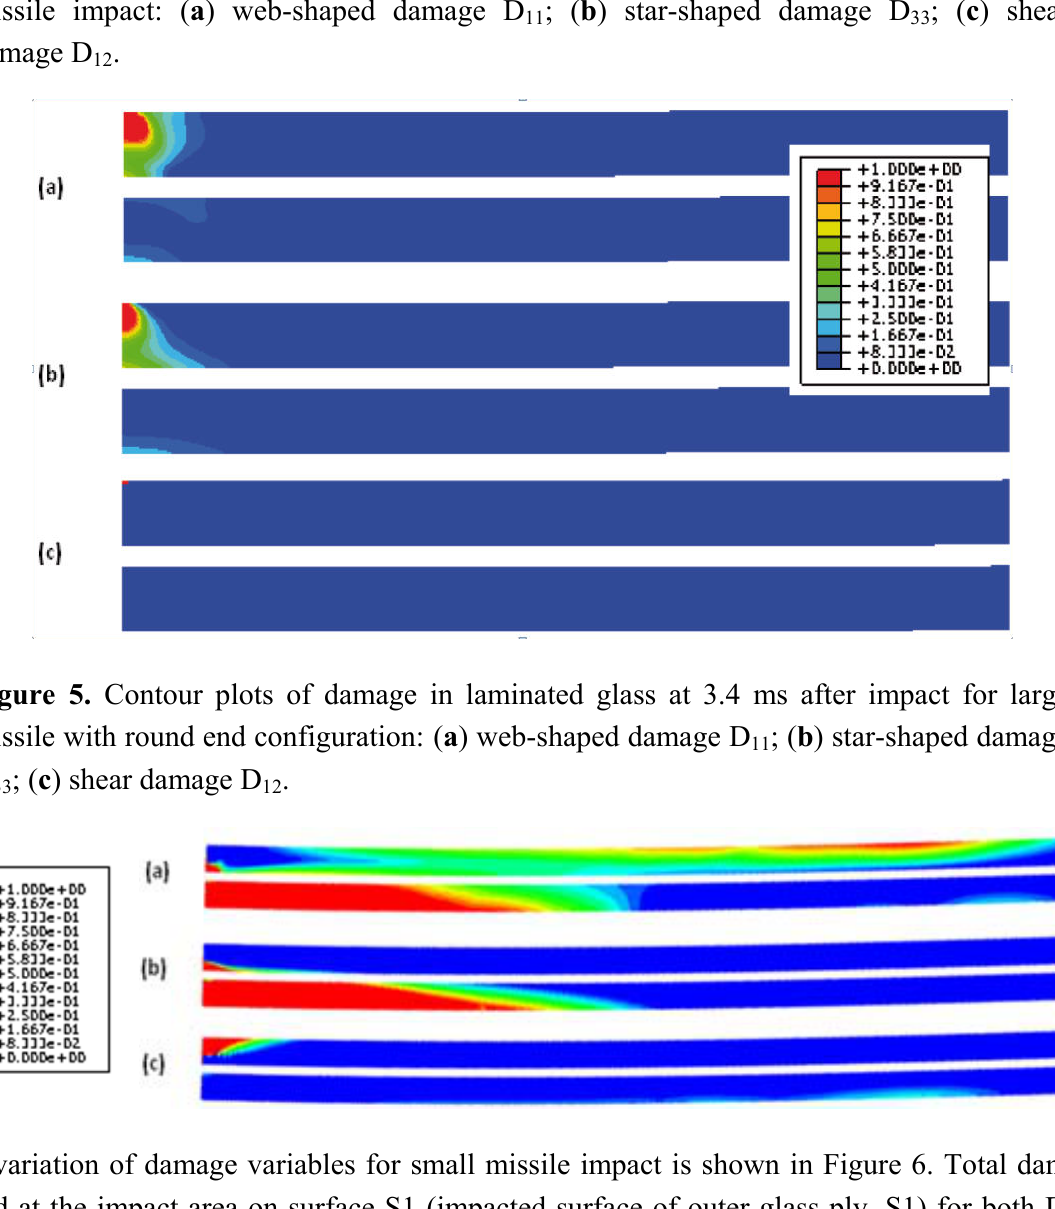
; ( b ) star-shaped damage D 11